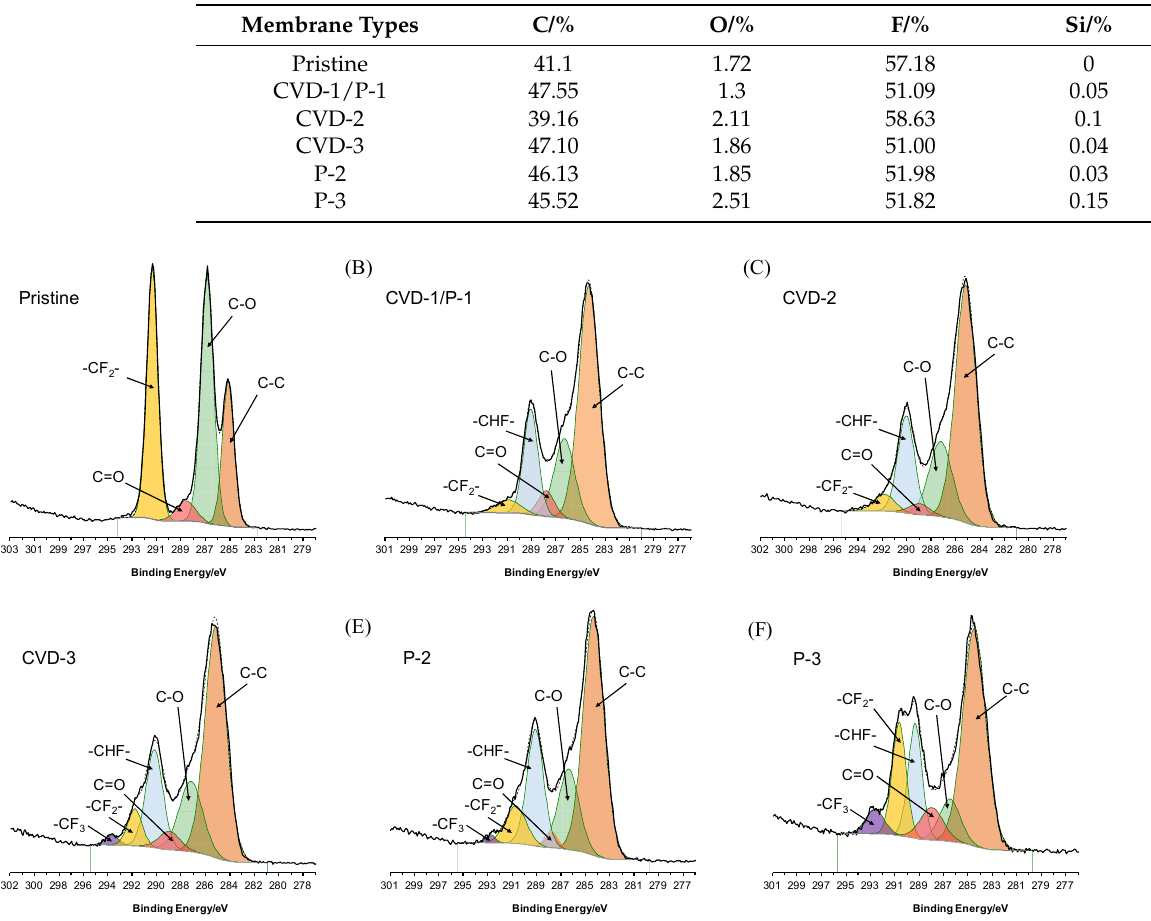
Figure 2. XPS spectra of C 1s binding energy of the pristine and modified membranes.